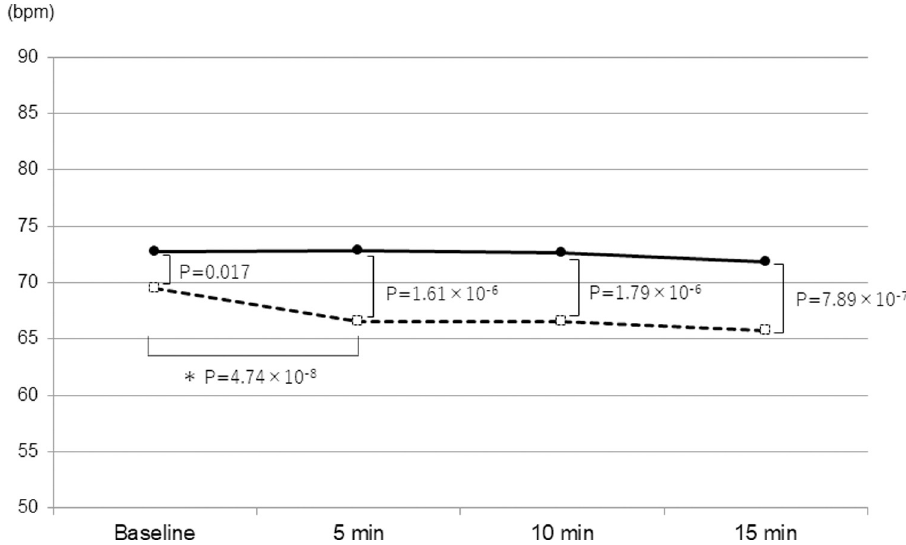
Fig 3. Time course of pulse rate in the DM group (solid line) and non-DM group (dashed line). P-values are the results of unpaired or paired ( � ) t -test.